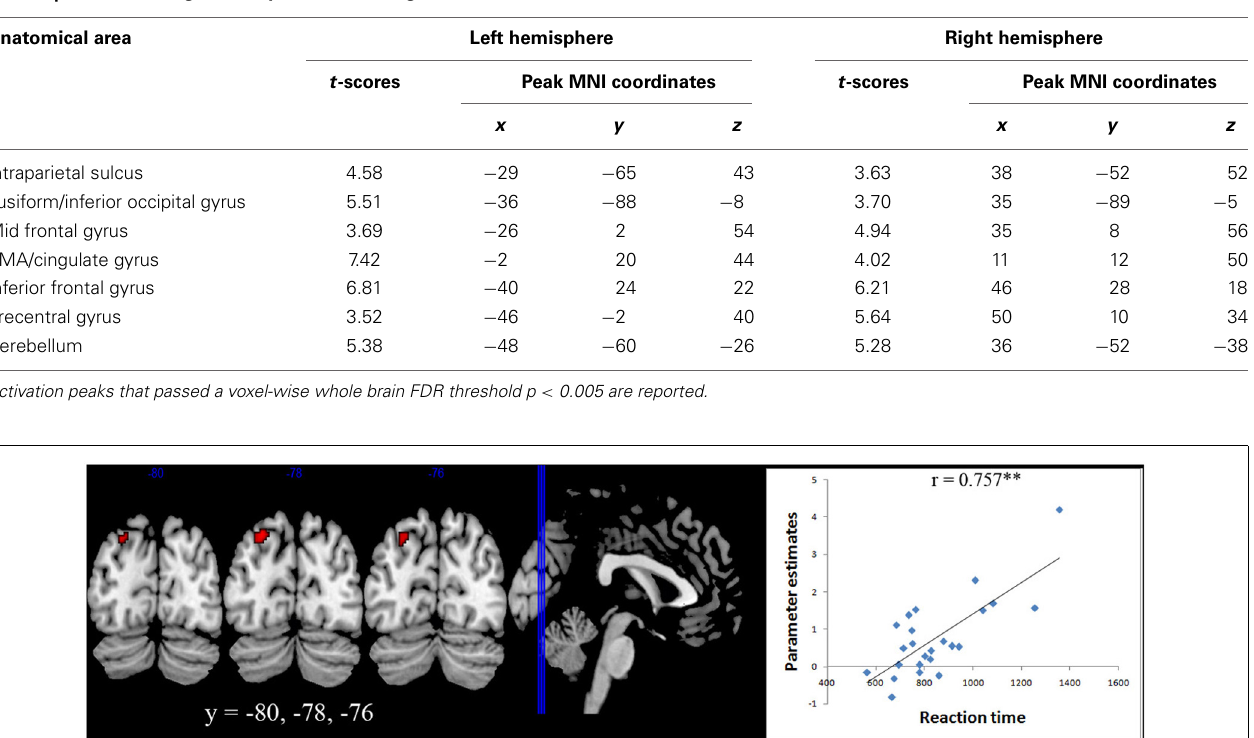
Table 4 | Brain areas significantly activated in Ng > Ar contrast.